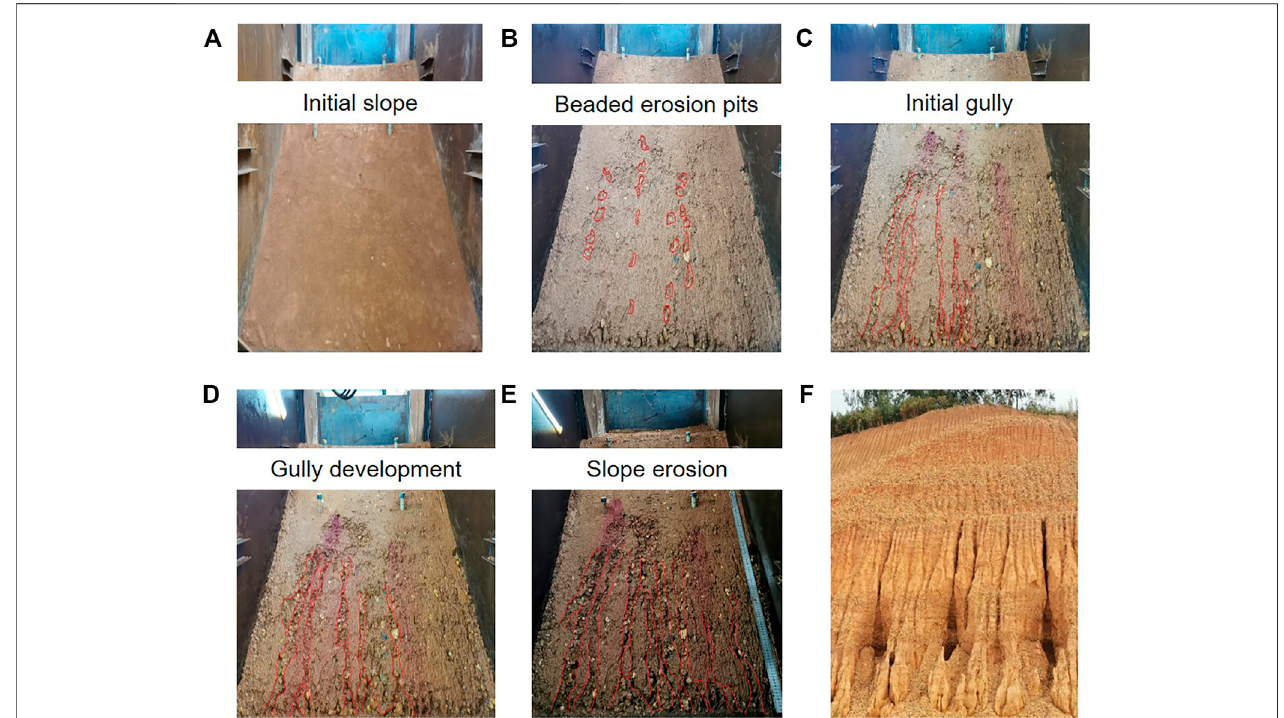
FIGURE8| Evolutionlawoferosiondamageofthetestslope(gravelcontent30%). (A) Initialslope (B) erosionpits (C) gully (D) gullydevelopment (E) slopeerosion (F) actual slope failure.